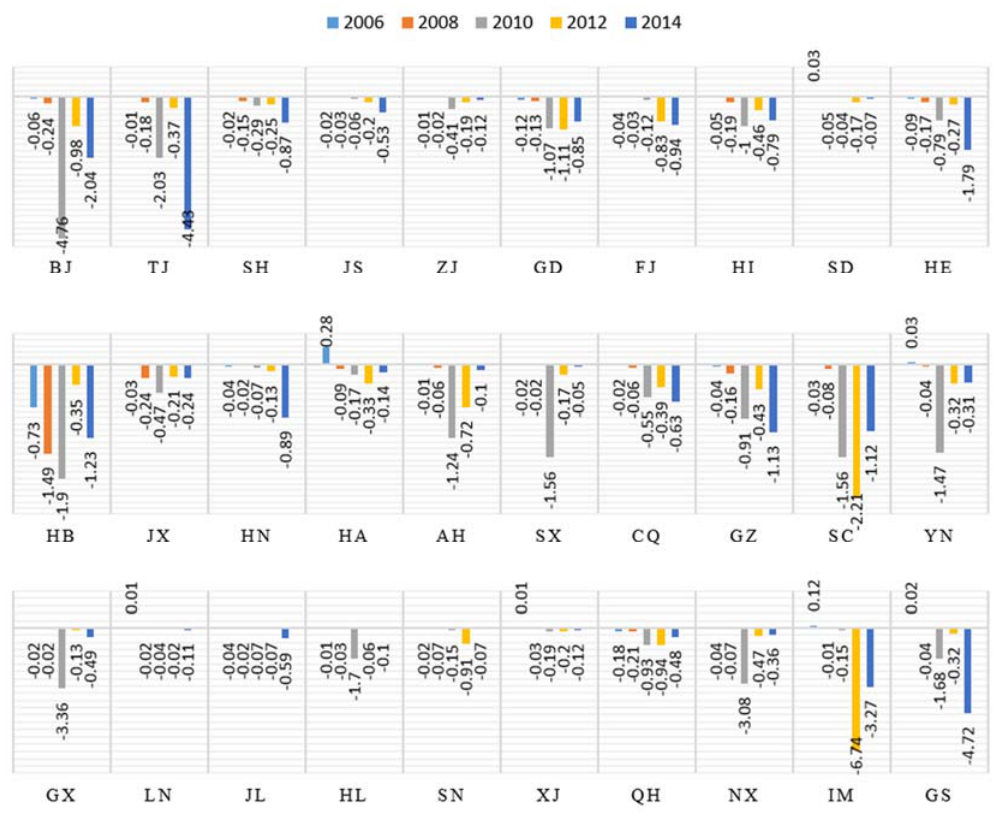
Figure 6. Contributions of value creation effect of 30 provinces in 2006, 2008, 2010, 2012 and 2014.